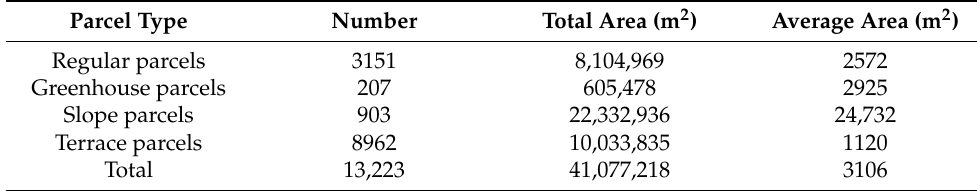
Table 2. Statistical table of different